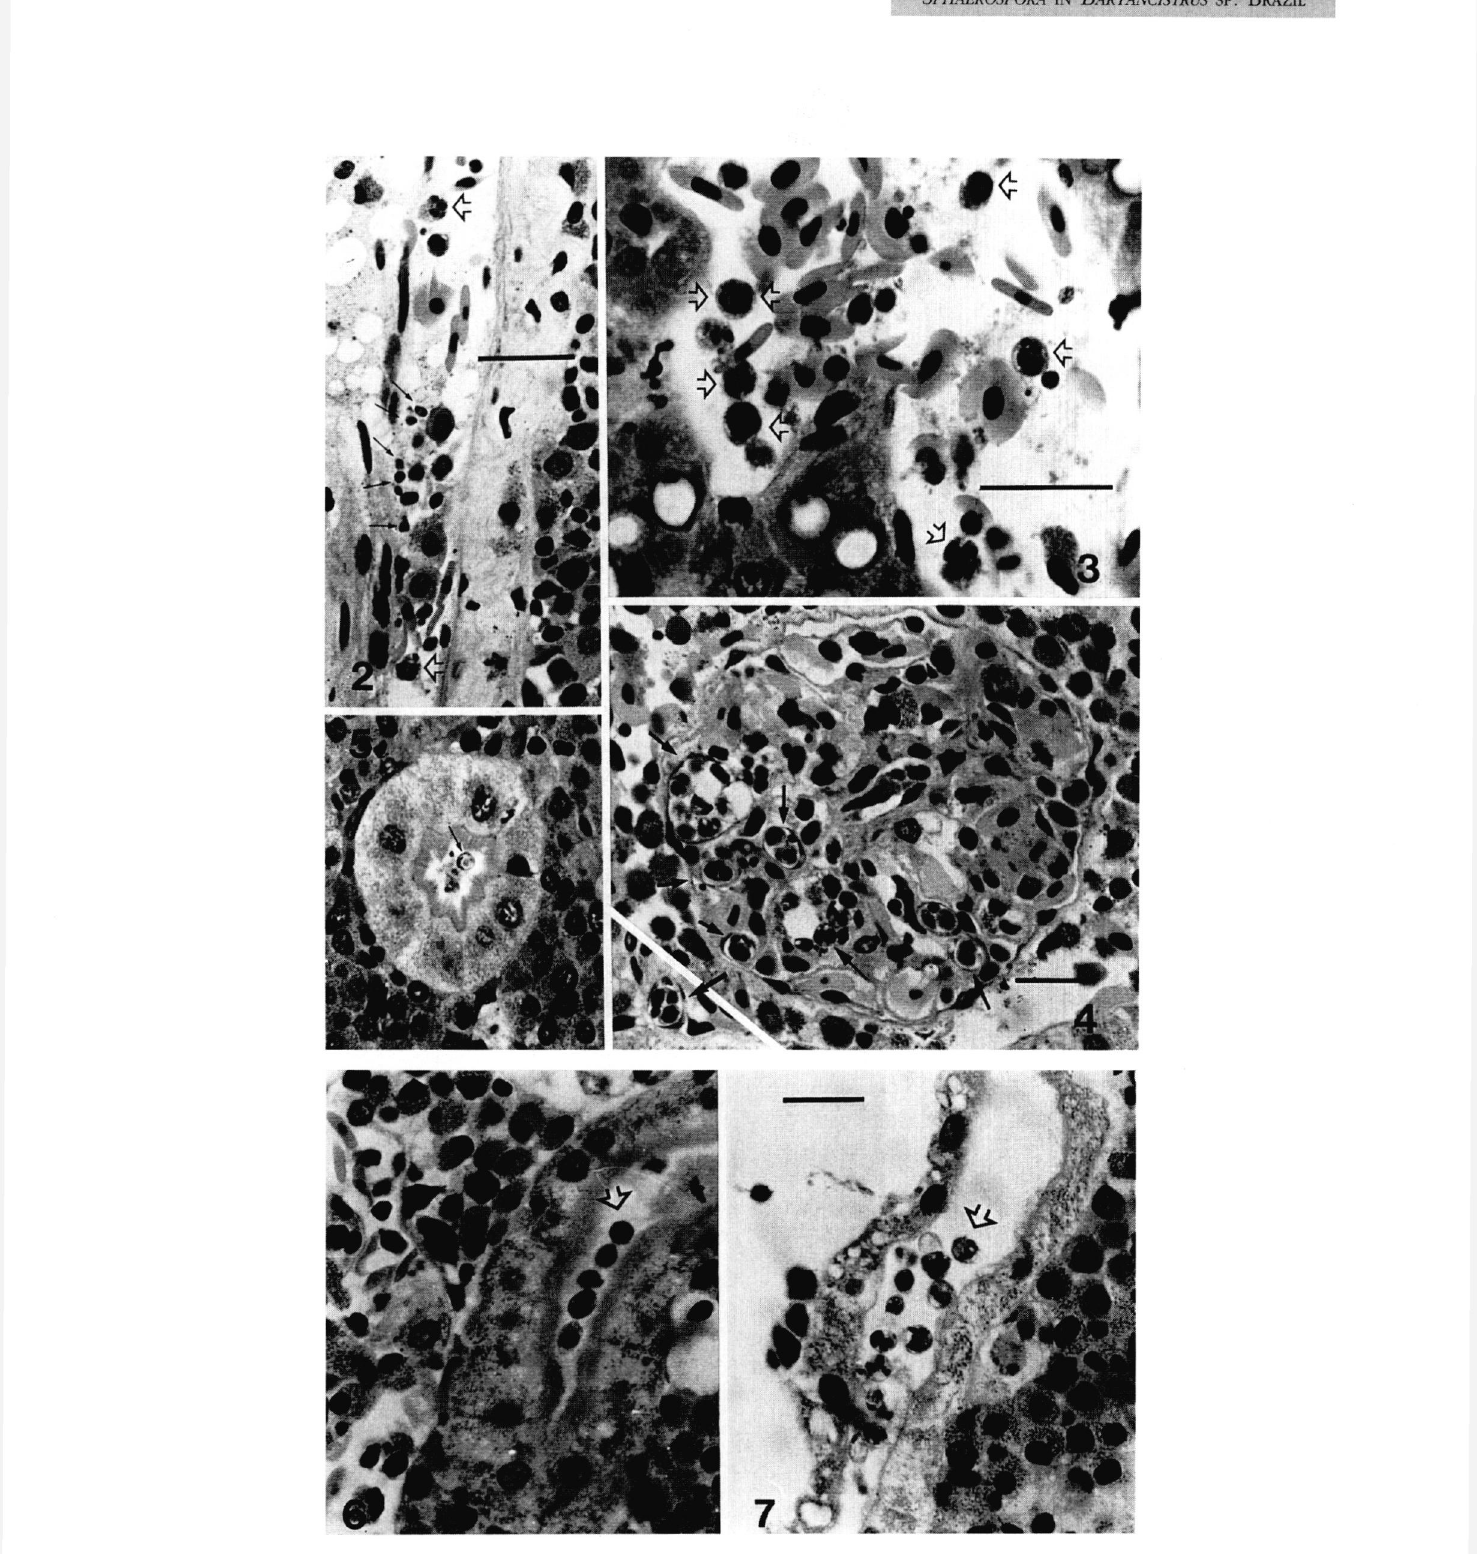
Figs. 2-5. - 2. Extrasporogonic blood stages of Sphaerospora sp.: primary, secondary (fine arrows) and tertiary cells (open arrows) in an hepatic blood vessel. 3. Enlarged view of a hepatic lacuna containing many fully developed extrasporogonic stages (open arrows). 4. Spo- roblastic stages within the glomerulus (arrows); annex-bold arrow: sporoblast in the periphery of a renal tubule. 5. Spores in the renal tubule lumen. Figs. 6-7. - Sporoblastic stages and spores in the renal tubule (open arrows) (Scales = 20 pm, Figs. 4 & 5 and 6 & 7 same magnification).